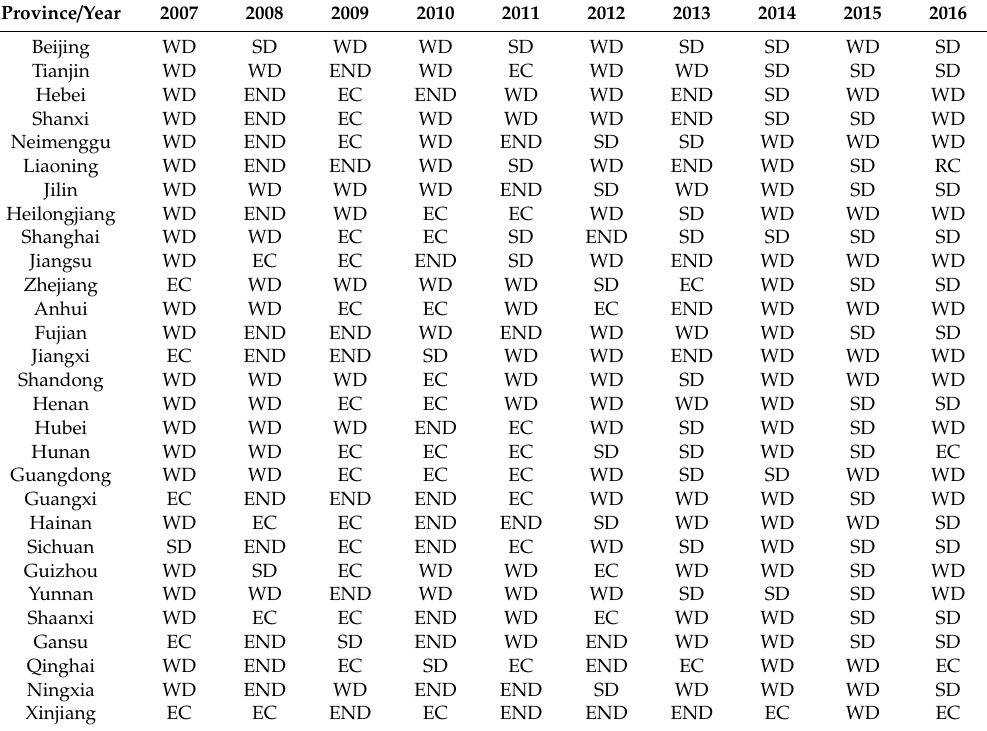
Table 4. Decoupling elastic coe ffi cient of CO 2 in 29 provinces of China for the period 2007–2016. Province /